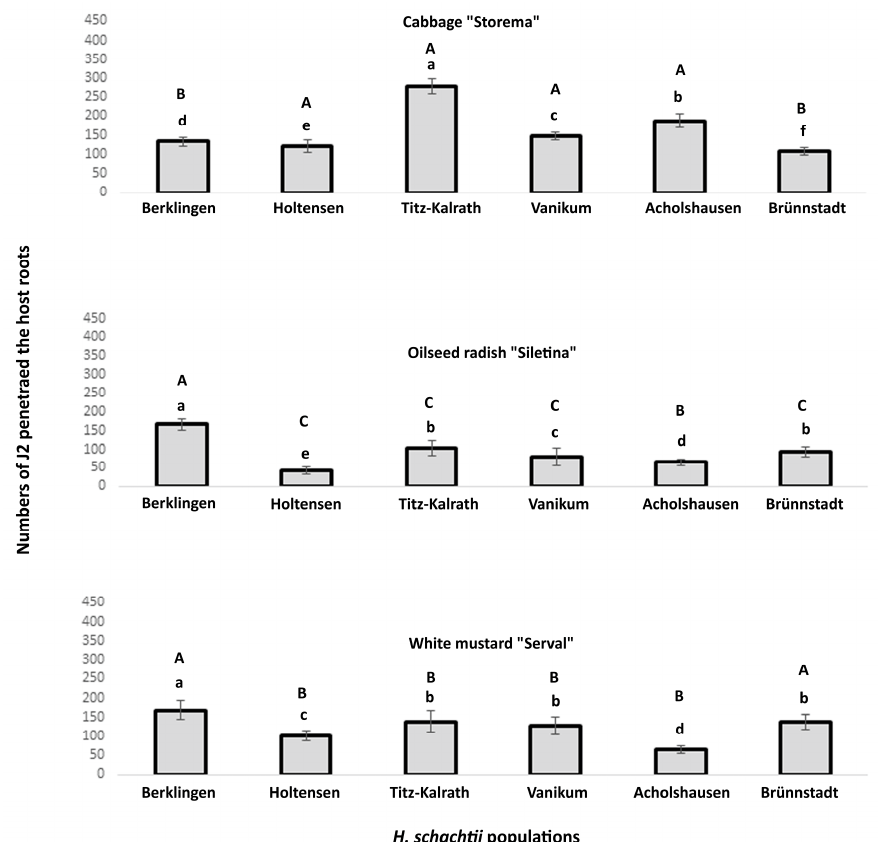
Figure 2. Numbers of second-stage juveniles (J2) from six populations of H. schachtii that penetrated roots of the susceptible cabbage ( Brassica oleracea L., cv. Storema) or susceptible oilseed radish ( Raphanus sativus L., cv. Siletina) or resistant white mustard ( Sinapis alba L., cv. Serval). In total, 450 J2 were added to a seven-day seedling grown in the loess substrate and incubated under greenhouse conditions (20/16 °C for a 16/8 h day/night cycle) for seven days. The counting was for J2 in the roots, stained by acid fuchsin. (a,b,c,d,e,f) compare the mean numbers of J2 among populations that penetrated the same plant species. (A,B,C) compare the mean numbers of J2 of the same population that penetrated the three plant species. Di ff erent le tt ers indicate signi fi cant di ff erences (Wilcox’s test, p < 0.05, n = 8).